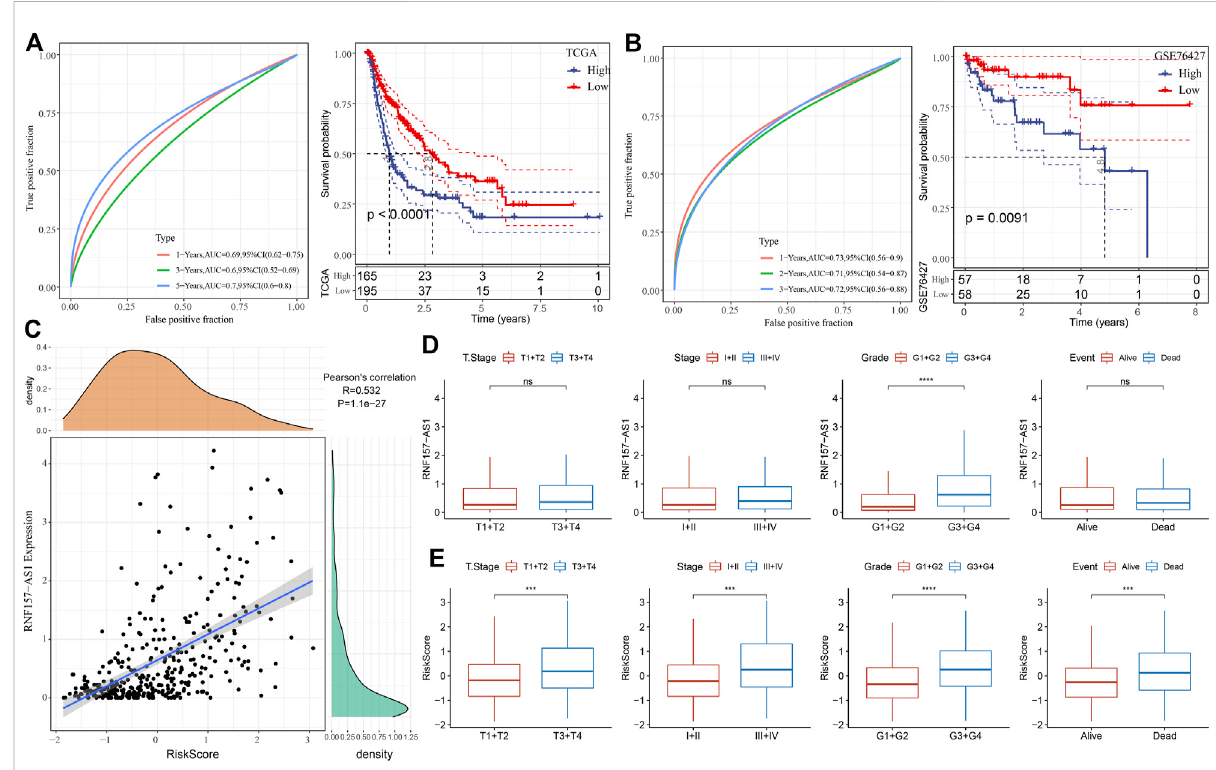
FIGURE 4 Performance of the four-gene risk model. (A) ROC analysis of survival plots of the risk model in the TCGA dataset. (B) ROC analysis of survival plots of the risk model in the GSE76427 dataset. (C) Pearson correlation analysis between RNF157-AS1 expression and risk score. (D) RNF157-AS1 expression of HCC samples grouped by different clinical features. (E) Distribution of risk scores for different clinical features. Log-rank tests were conducted in (A, B) . Wilcoxon tests were performed in (D, E) . ns: no signi fi cance. *** p < 0.01, **** p <